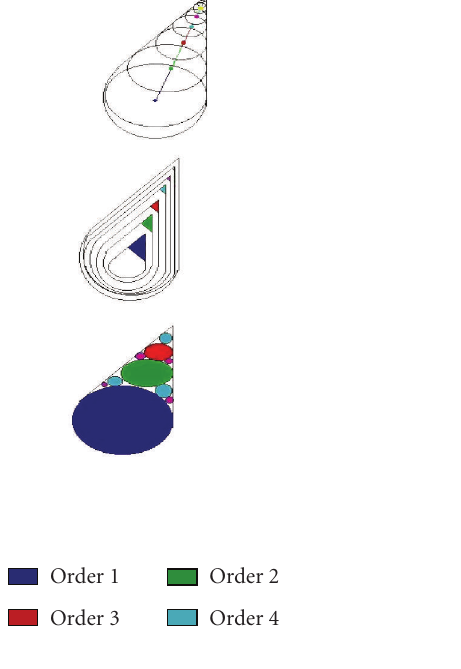
Figure 3.1. Schematic representations of pore-channel, -throat, and